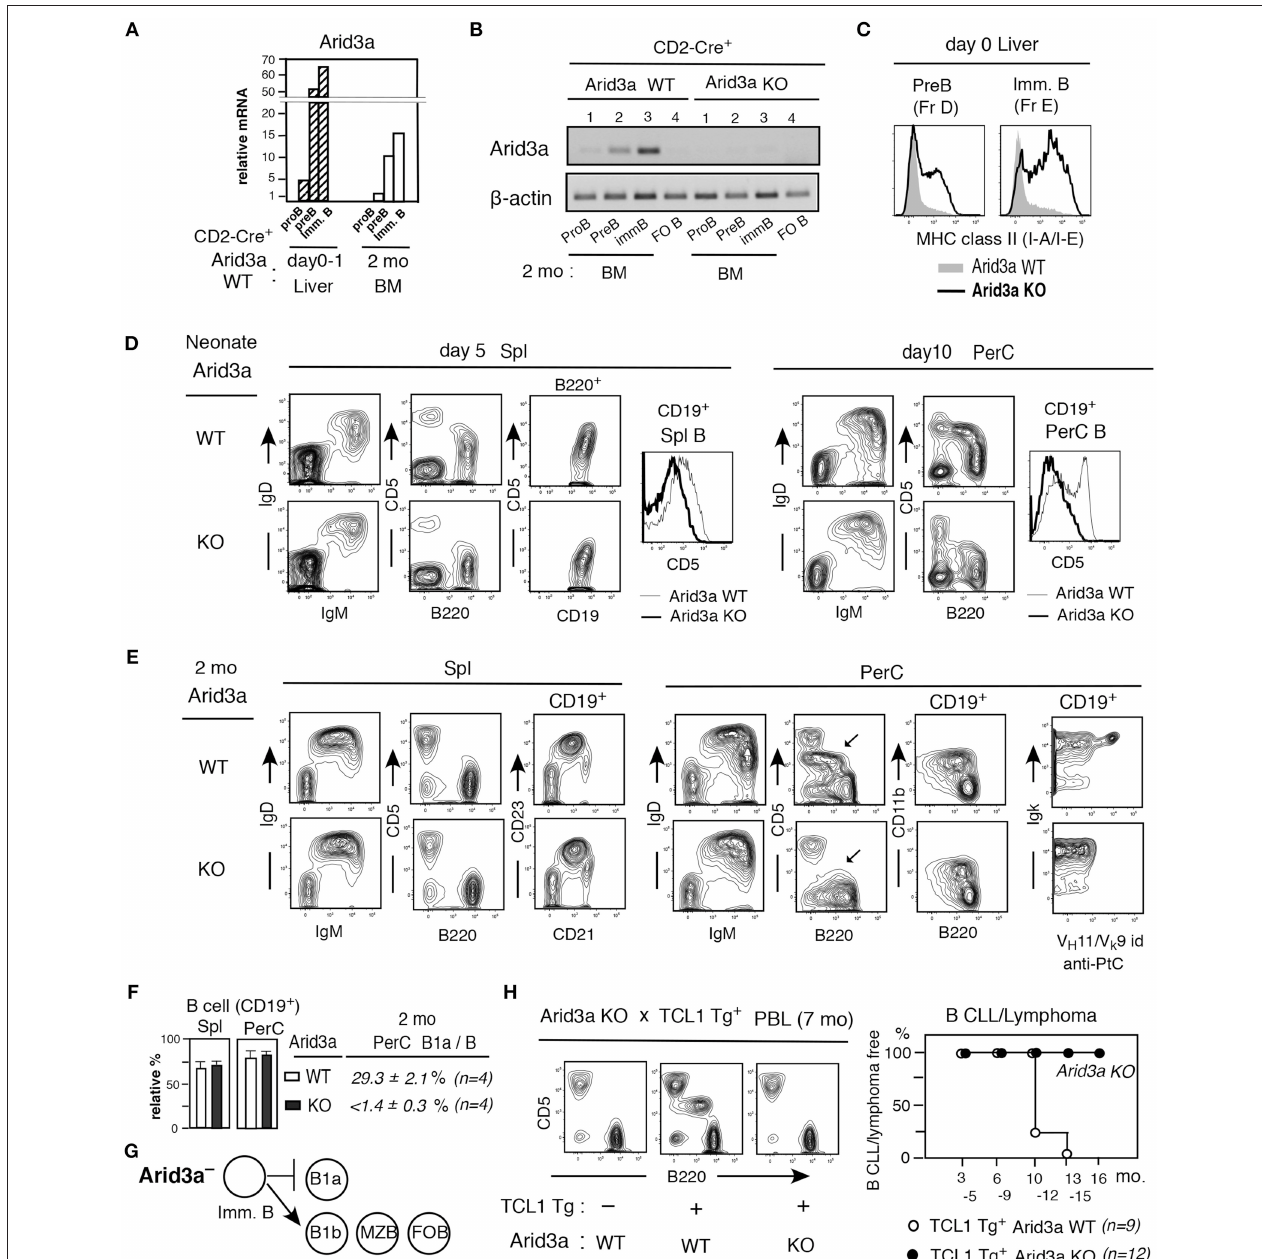
FIGURE 3 | Arid3a KO mice exhibit adult-type B cell development without B1a cell generation. (A) Arid3a qRT-PCR of B-lineage in CD2-Cre + Arid3a WT mice in d0-1 liver and 2 mo BM. n = 2 each; mean. (B) Arid3a PCR of 2 mo BM B-lineage and spleen FO B cells in CD2-Cre + Arid3a WT and KO littermates. (C) MHC class II staining of pre-B and immature B cells in d0 Arid3a KO and WT littermates. Represent of 3 mice each. All showed similar increases in Arid3a KO compared to WT. (D) Neonatal spleen (day 5) and PerC (day 10) analysis of Arid3a KO and WT littermates, and CD5 level comparison in B cells (CD19 + ). Three mice each showed similar results. (E,F) Adult (2 mo) Arid3a KO and WT spleen and PerC analysis. B1a cells in PerC are marked. Percentage of total B cells in spl and PerC in lymphoid area ( n = 4 each; mean ± s.e.) and B1a cells in total B cells in PerC. (G) Arid3a deficient mouse generates B1b, MZ B, and FO B cells, and loss of B1a cell generation. (H) PBL crossed with TCL1 Tg-CD2-Cre + mice. CLL/lymphoma incidence difference in TCL1 Tg expressing Arid3a KO vs WT littermates.